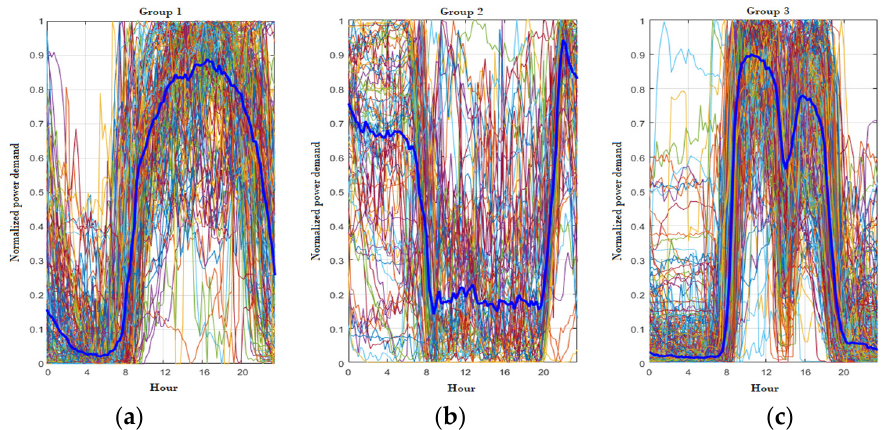
Figure 4. Groups obtained through K-means clustering for commercial customers with installed